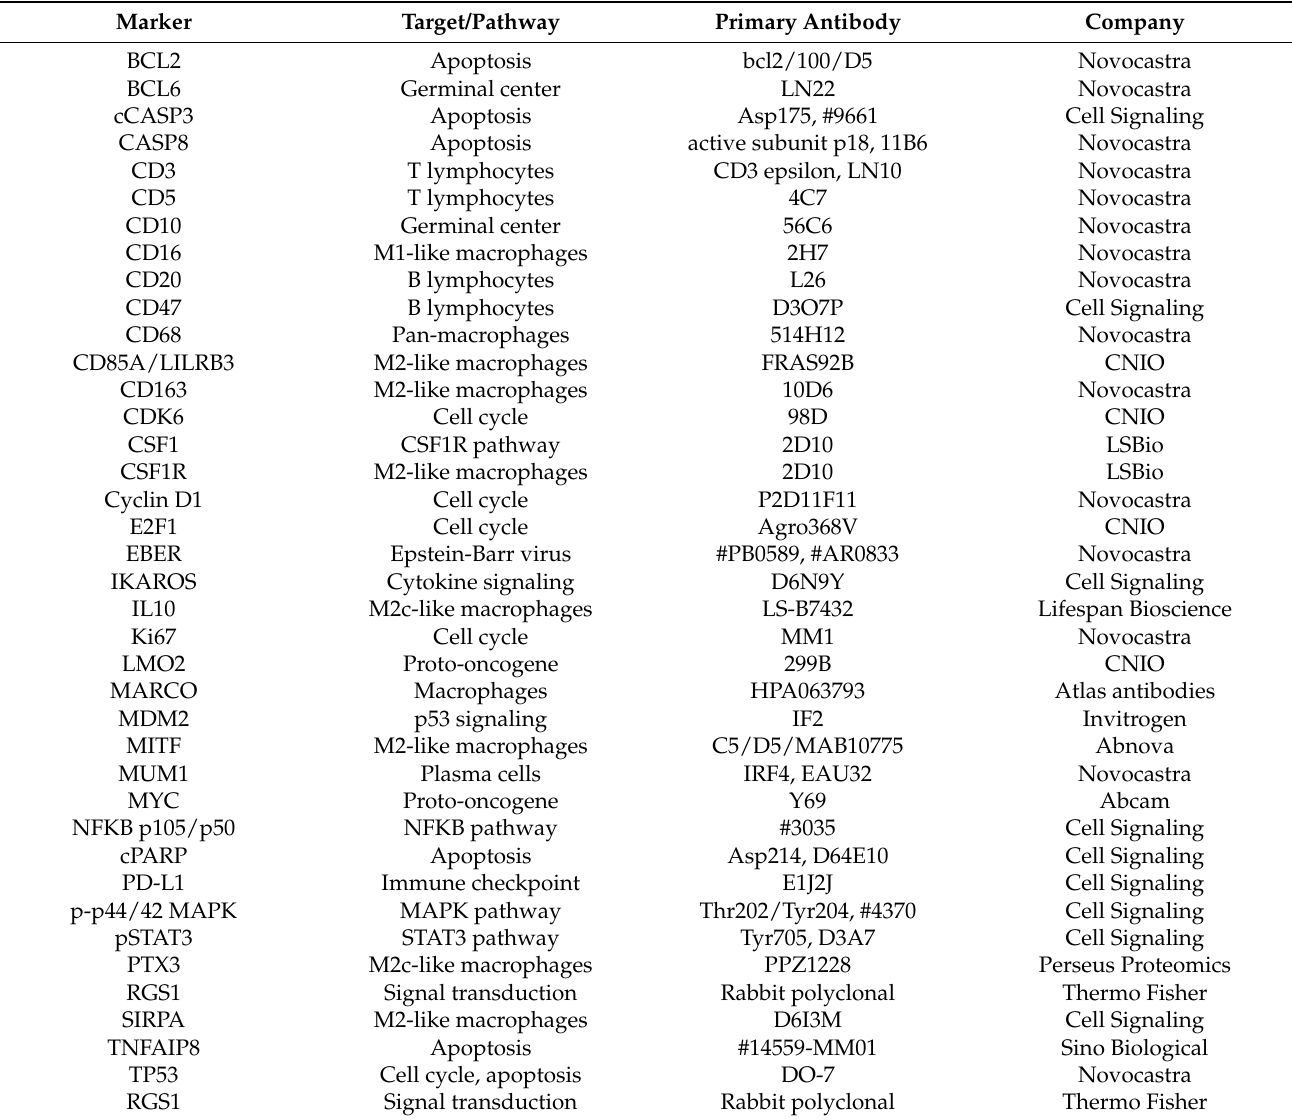
Table 1. Immunohistochemical markers used in lymphoma cases of Tokai University, School of